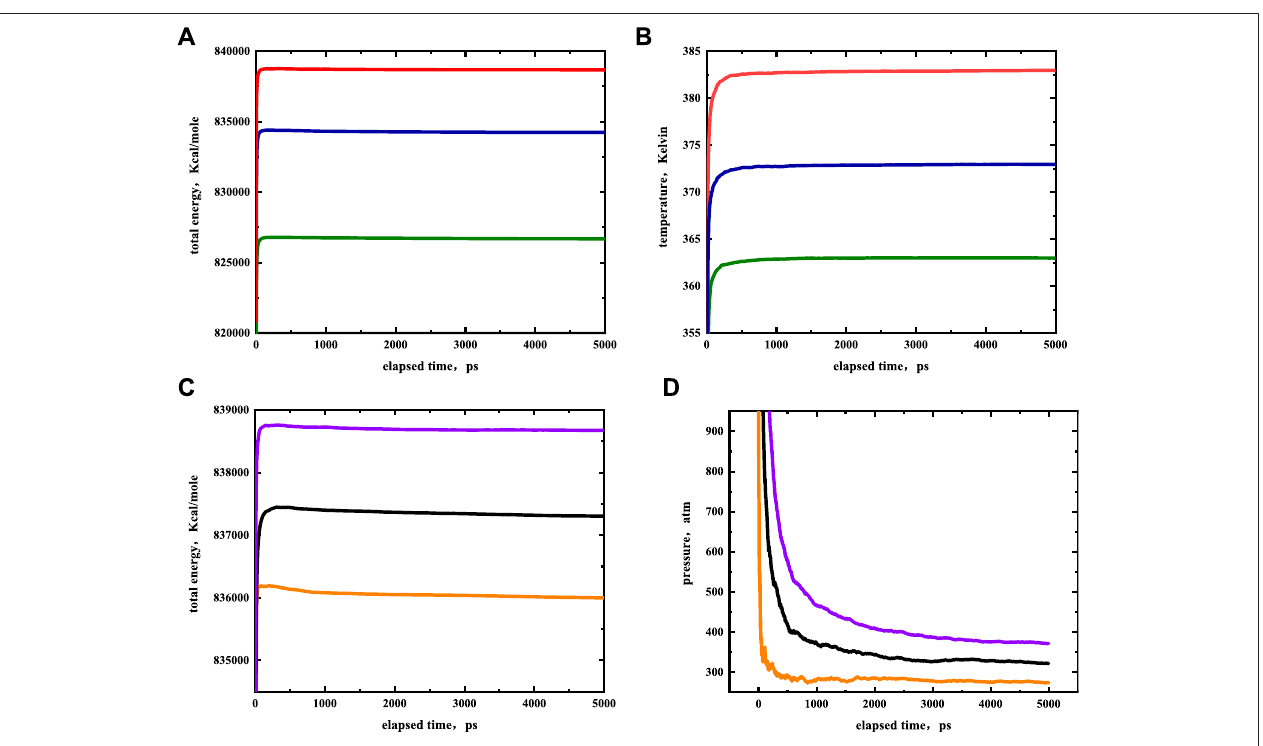
FIGURE 4 | Simulation results of nC 19 H 40 in equilibrium stage at different temperatures (A,B) and pressure (C,D) . The red, blue, green colors represent temperatures of 383, 373, 363 K, the purple, black and orange colors represent pressures of 372, 322, 272 atm, respectively.